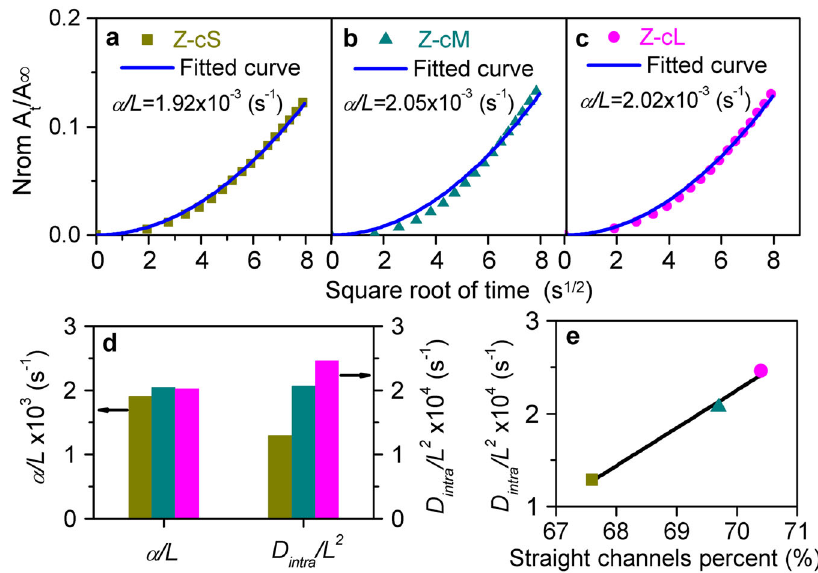
Fig. 5 The intracrystalline and surface diffusion behaviors of C 4 = molecule in H-ZSM-5 zeolites. Initial uptake rates of butene molecule over H-ZSM-5 zeolites: a Z-cS, b Z-cM, and c Z-cL. d Surface permeability ( α / L ) and intracrystalline diffusion rates ( D intra / L 2 ) of butene molecule derived by the uptake rates of H-ZSM-5 samples (as presented in Figs. 3a and 4a – c) following Eq. 2. e Correlation of straight channel percent computed in Table 1 with the intracrystalline diffusion rates ( D intra / L 2 ) of butene molecule. The error bars are smaller than the data points in Fig. 5e.